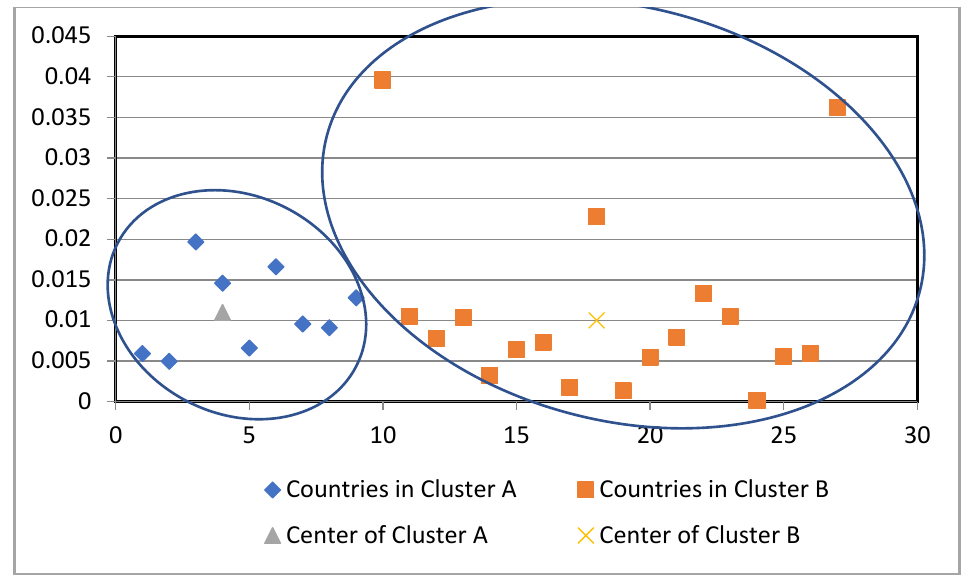
Figure 5. K-means clustering results. Table 3. Descriptive statistics of the